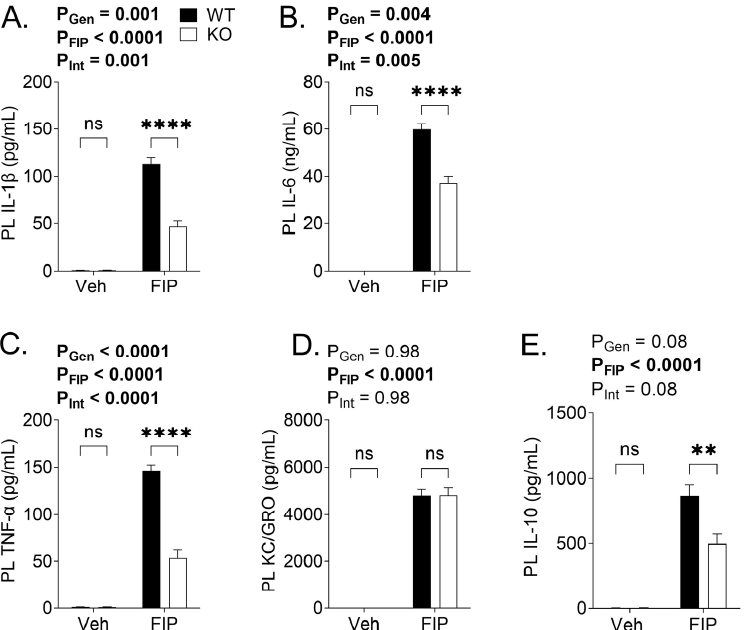
Figure 4. Peritoneal lavage (PL) cytokine profiles in wild-type (WT) and OSMR type II receptor knockout (KO) mice subjected to fecal slurry (FS)-induced peritonitis (FIP) or treated with vehicle (Veh). PL samples collected 18 h post-injection of Veh or FS were analyzed for the levels of ( A ) IL-1 β , ( B ) IL-6, ( C ) tumor necrosis factor alpha (TNF α ), ( D ) keratinocyte chemoattractant (KC)/human growth-related oncogene (GRO), and ( E ) IL-10. The p values reflect the outcomes of 2-way analysis of variance; Sidak post-hoc tests outcomes are shown as ** p < 0.01, **** p < 0.0001, ns not significant. Each bar represents n = 3–14 mice.